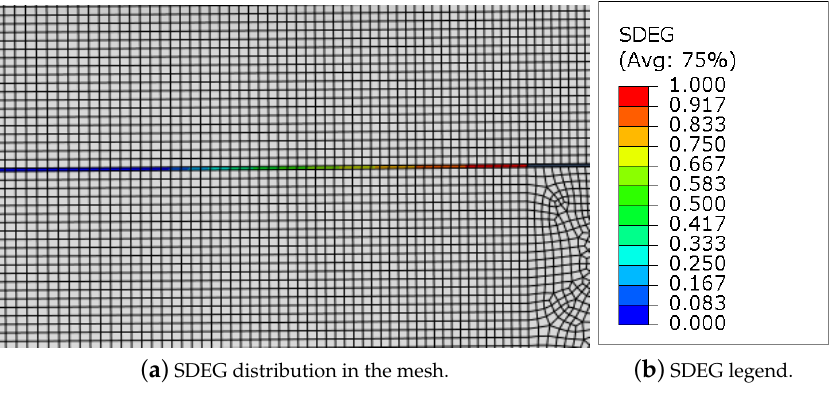
Figure 7. Stiffness degradation, SDEG, parameter in Abaqus ®